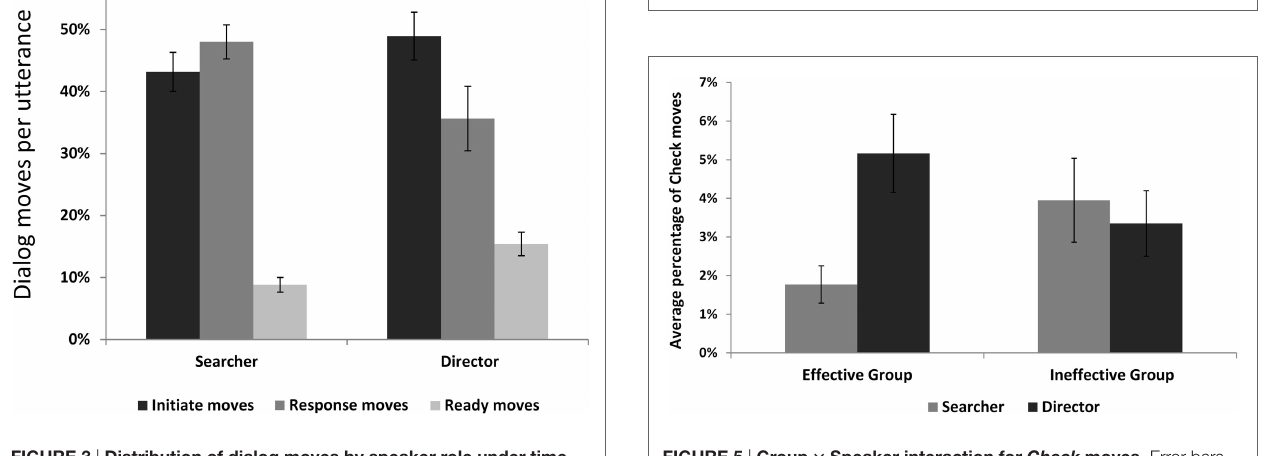
FigUre 4 | group effect for disfluency rate .